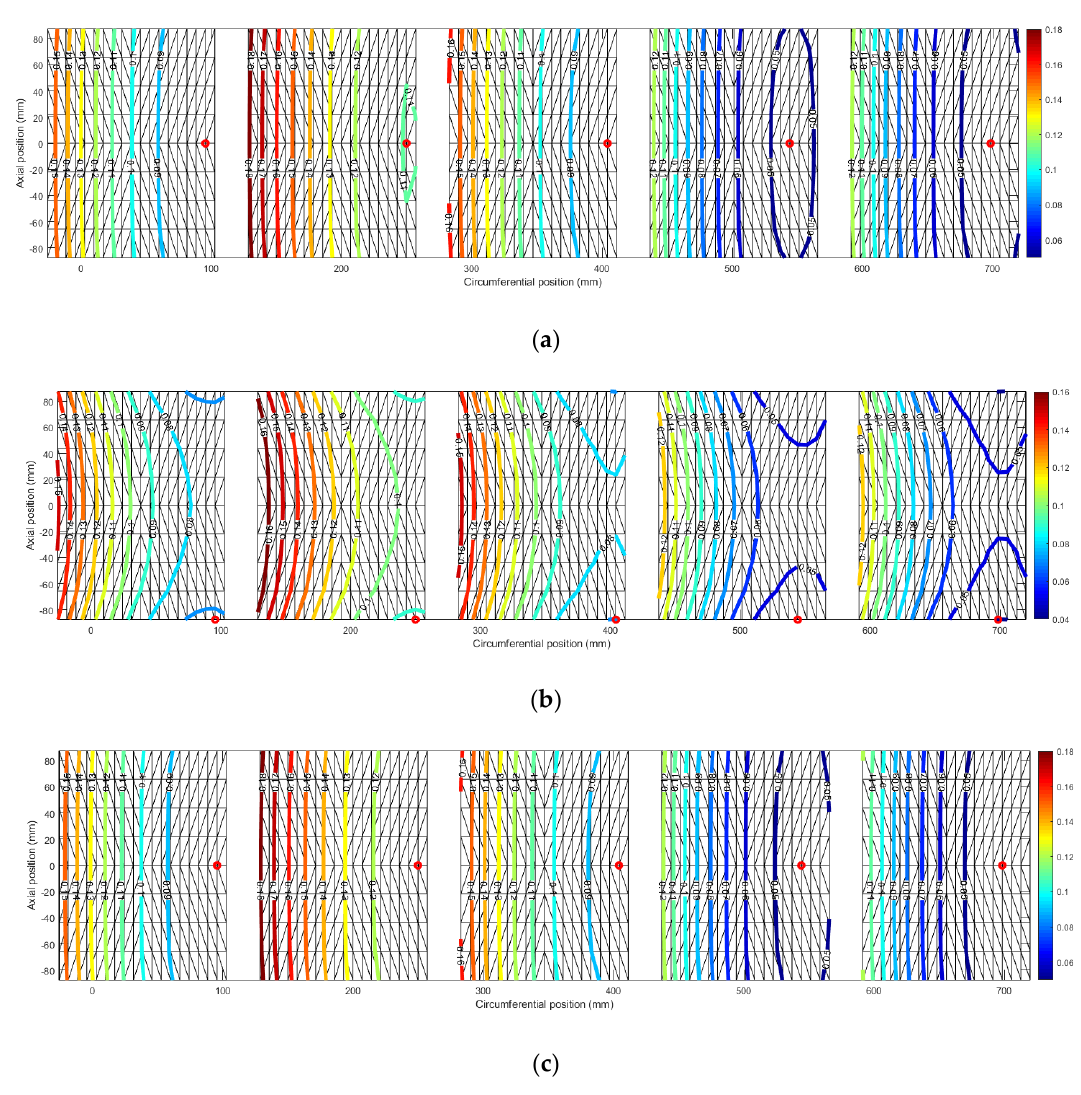
Figure 13. Fluid film thickness distribution: ( a ) model no. 2 ( T Pad = 80 °C, T Shaft = 50 °C, T Lube = 50 °C); ( b ) model no. 4, ( T Pad = 50 °C, T Shaft = 80 °C, T Lube = 50 °C); ( c ) model no. 6, ( T Pad = 50 °C, T Shaft = 50 °C, T Lube = 80 °C).